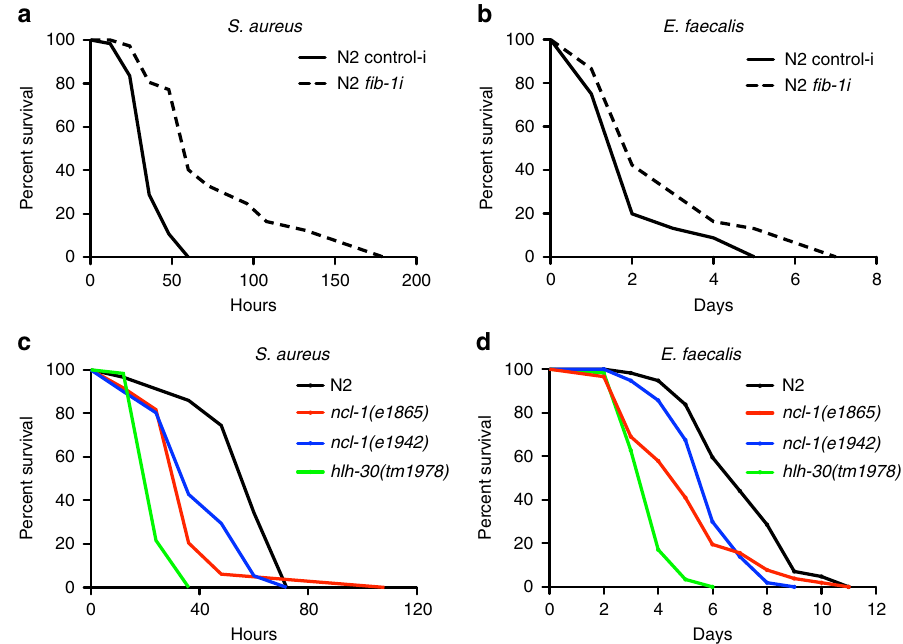
Fig. 1 fi b-1 / fi brillarin regulates bacterial infection resistance in C. elegans . a , b fi b-1 knockdown improves survival of wild-type N2 worms upon S. aureus and E. faecalis infection ( P < 0.0001). c , d ncl-1 mutants ( e1865 and e1942 ) are short-lived compared to wild-type N2 upon infection with S. aureus and E. faecalis ( P < 0.0001). hlh-30(tm1978) served as a control for infection. Survival experiments were performed three times independently. P -values were calculated by log-rank